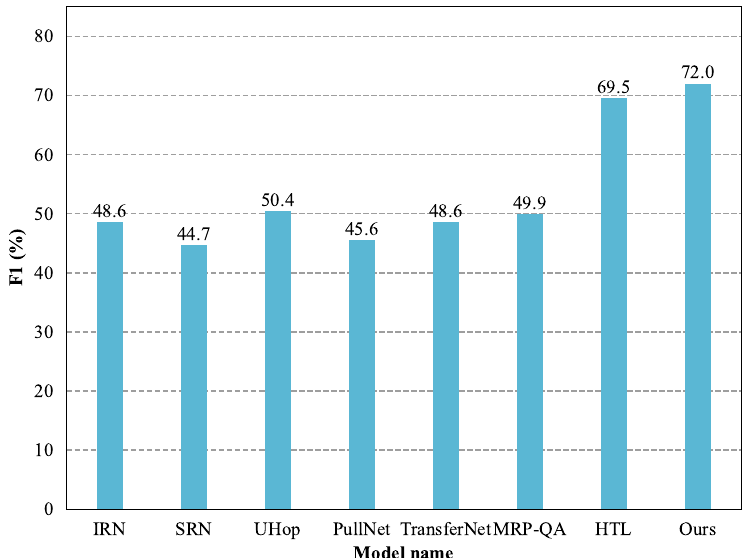
Figure 8. Performance comparison of the model on CWQS dataset.